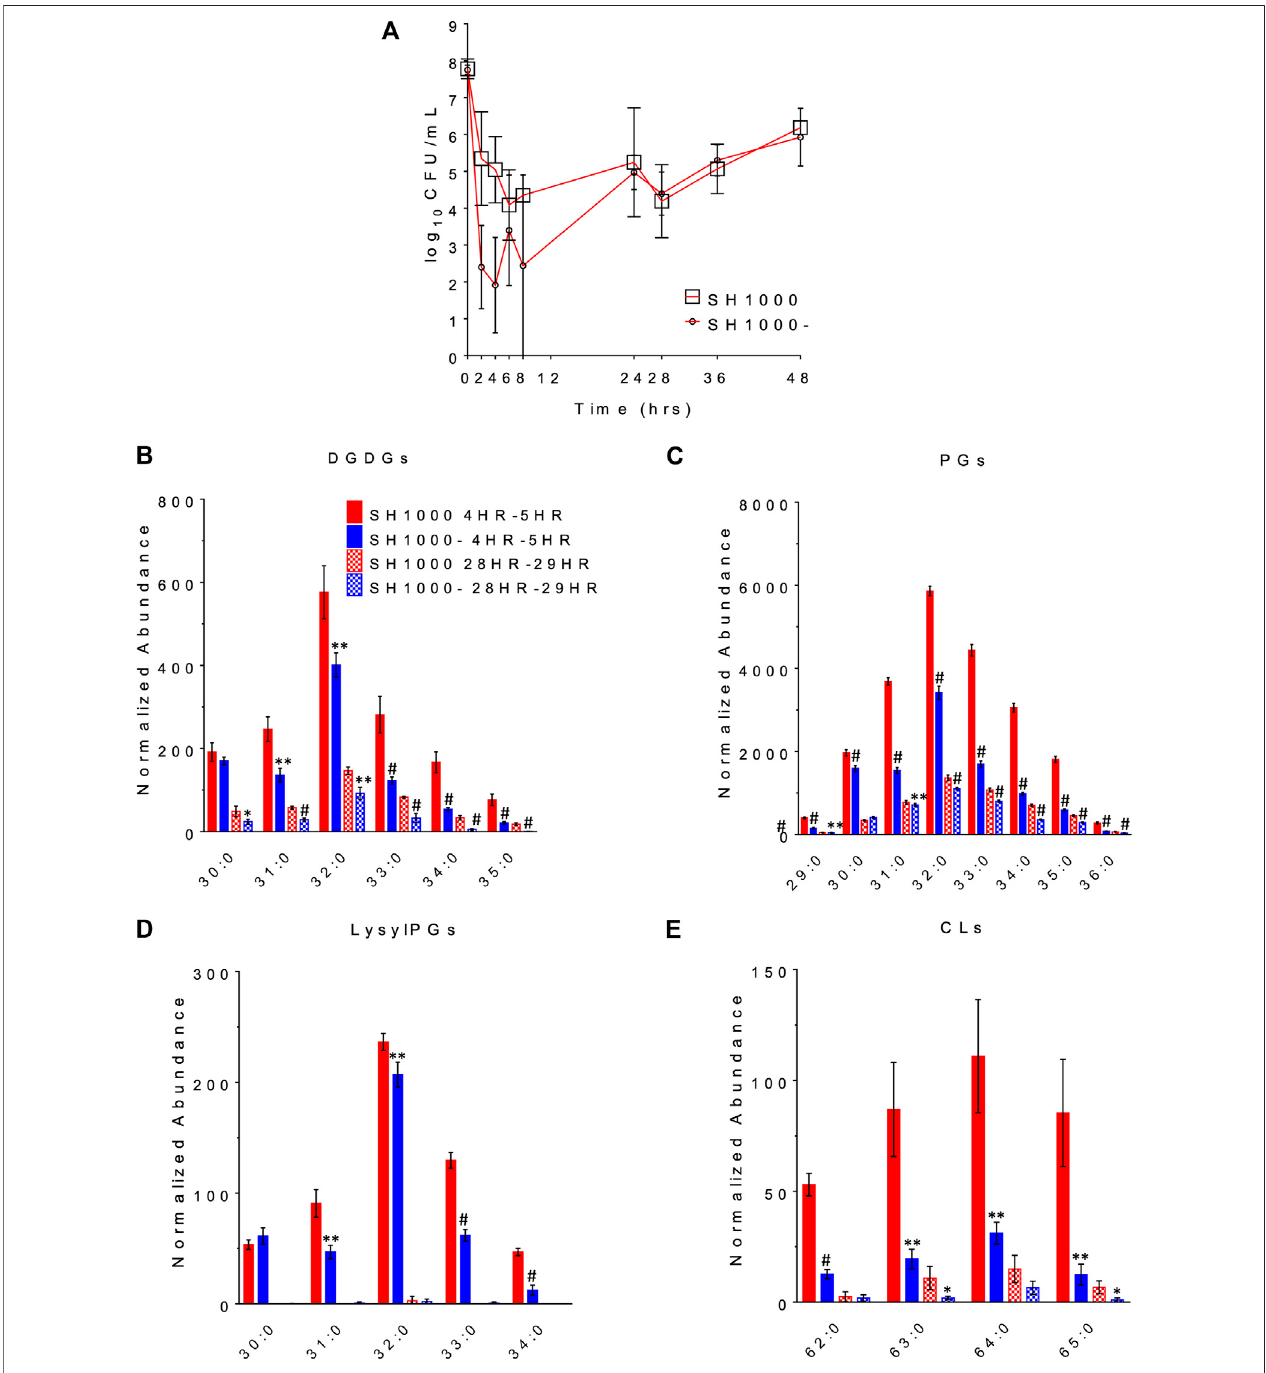
FIGURE3| Thesurvivalprofile (A) andlipidpro fi leduring4HR-5HRand28HR-29HR (B – E) ofSH1000andSH1000-inthepharmacokinetics/pharmacodynamics (PK/PD) model of daptomycin exposure. Individual lipid species are represented as the number of carbons: the degree of unsaturation in the fatty acid chains. DGDGs, diglucosyl-diacylglycerols; PGs, phosphatidylglycerols; LysylPGs, lysyl-phosphatidylglycerols; CLs, cardiolipins. # p < 0.001; **0.001 < p < 0.01; *0.01 < p < 0.05 (Student ’ s t -test, two-tailed, equal variance).